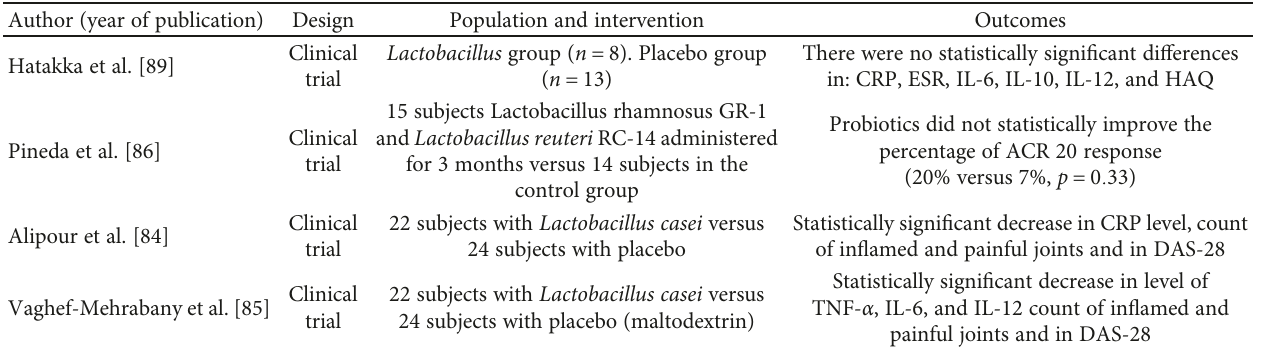
Table 3: Summary of studies evaluating the e ff ect of probiotics on the level of rheumatoid arthritis activity. Author (year of